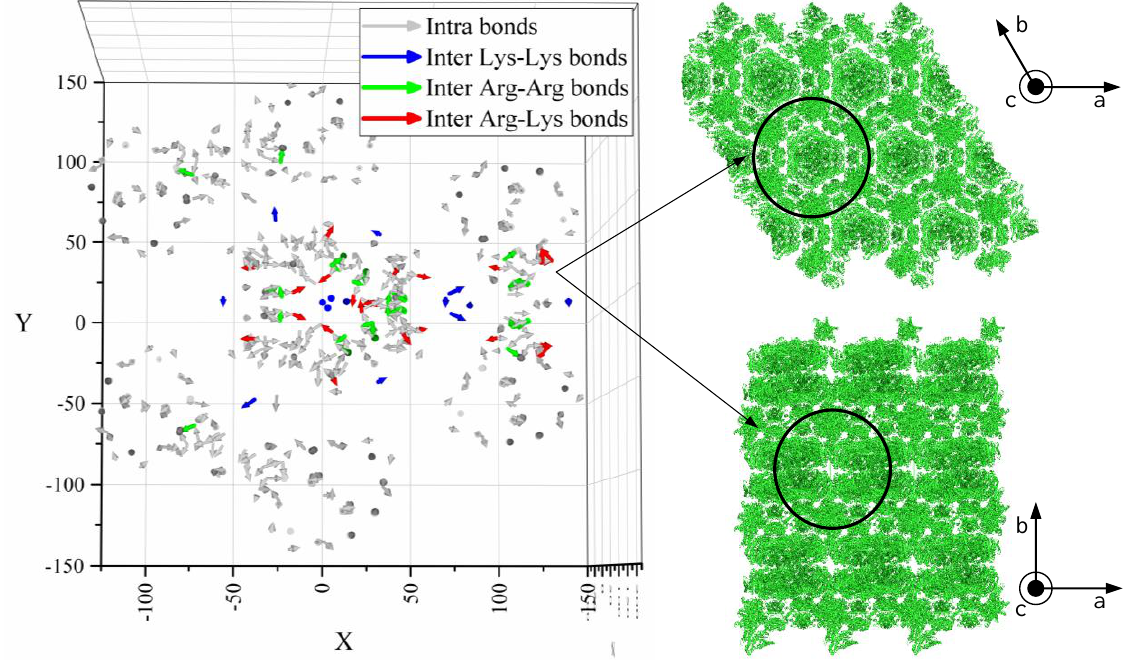
Figure 12. Graphical illustration of the intra- and intermolecular bonds with a maximum distance of 10 Å within the crystal packing composed of several protein molecules ( left ) and their possible occurrence within a supercell ( right ). Reprinted with permission from [31]. Copyright (2019) American Chemical Society.